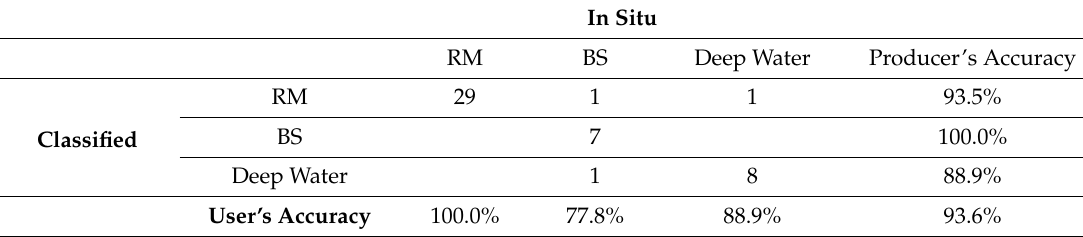
Table 1. Confusion matrix depicting the agreement of earth observations classified data with respect to in situ surveys. RM, deep water, and